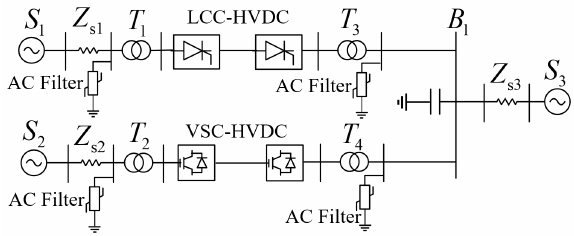
Fig. 1. Topology diagram of hybrid double infeed DC transmission system.